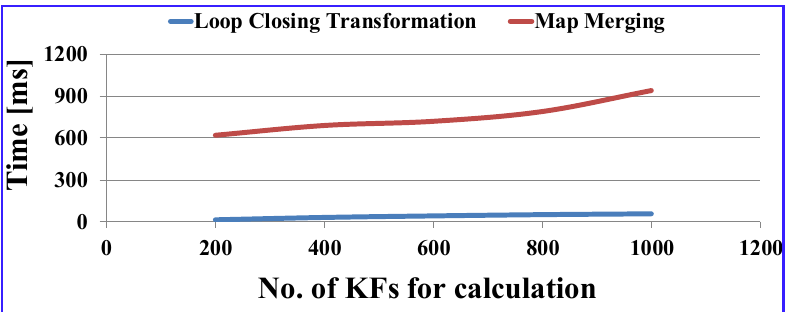
Figure 6. The server execution time against a given number of KFs to be processed. The values are tested on EuRoC MH01 to MH04 sequences with an average of 5